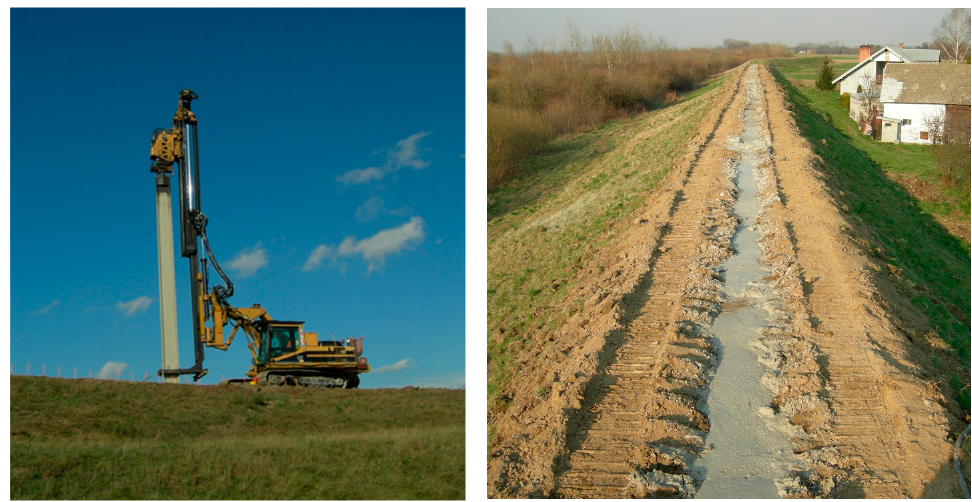
Figure 14. Pile driver with visible I-beam profile while making the shutter (by Ł ukasz Wójcik).